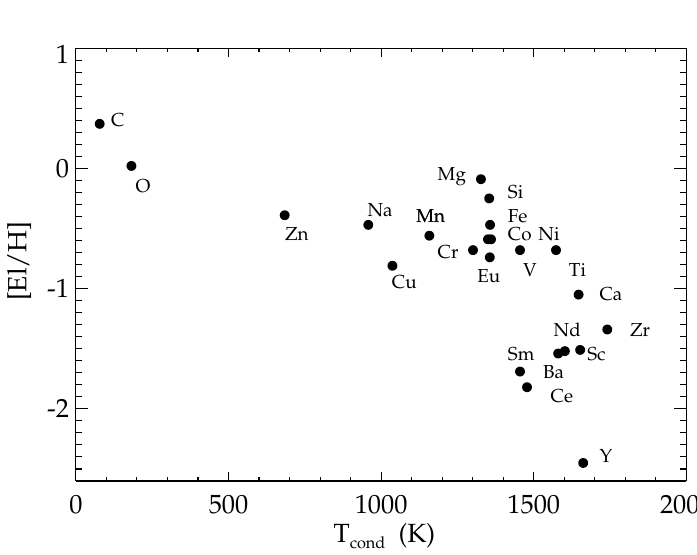
Fig. 3. Abundances of elements [El/H] for R Sct versus the corresponding condensa- tion temperatures (Lodders 2003). dance pattern. The elements with the condensation temperature T cond > 1300 K are selectively